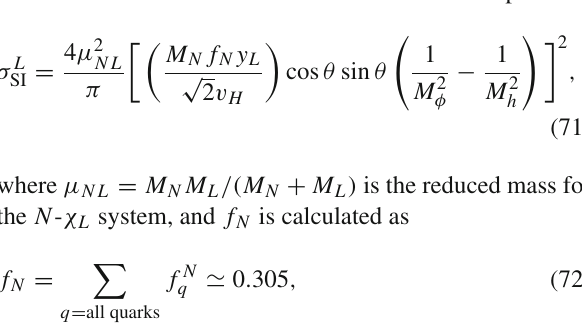
Fig. 7 The SI elastic cross section of Majorana fermions as a function of their masses. The black solid line is the current upper bound of XENON1T [109]. The green and yellow bands stand for the 1 σ and 2 σ bands,